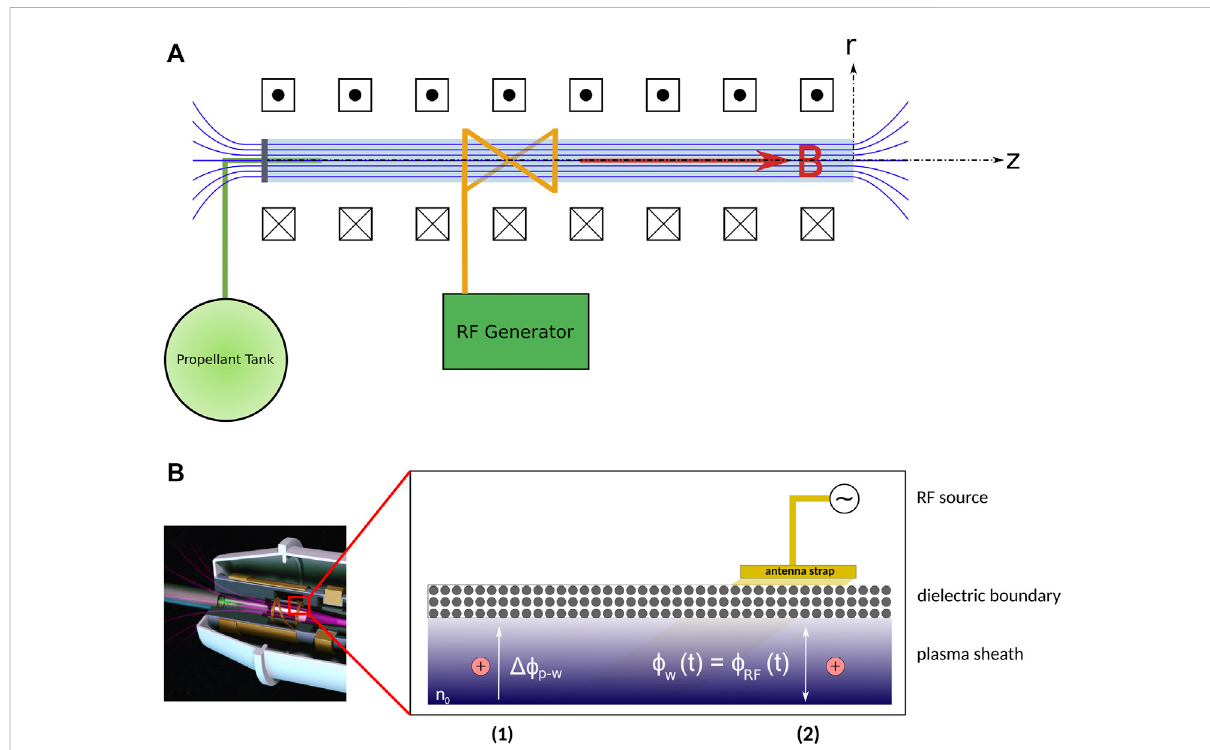
FIGURE 1 (A) A simpli fi ed diagram of a Helicon Plasma Source (HPS). (B) A representation of the main mechanisms of erosion present in Helicon Plasma Sources, reproduced from [2]. Region (1) describes the acceleration of ions towards the inner con fi nement surfaces due to the DC sheath and the fl oating negative potential present at the surface. Region (2) describes the acceleration of the ions due to the present of an external source of RF excitation, such as the terminals of the antenna used to excite the plasma